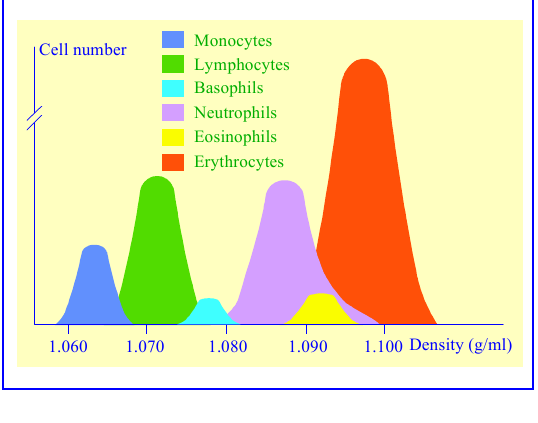
FIGURE 1. Density of human blood